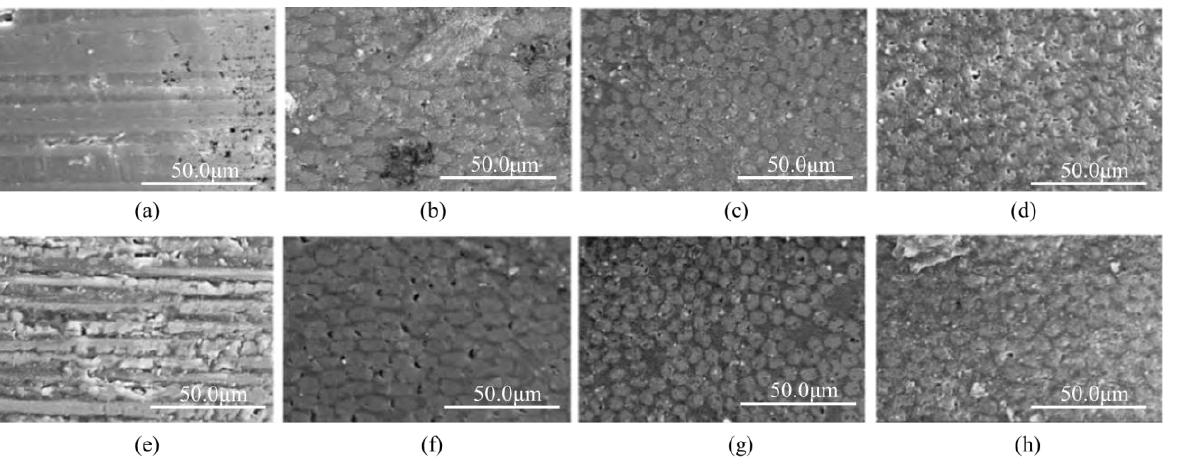
Figure 14. Surface morphologies of diced CFRP composites for metal-bonded blades at fiber orien- tations ( a ) 0°; ( b ) 40°; ( c ) 90°; and ( d ) 130° and for resin-bonded blades at fiber orientations ( e ) 0°; ( f ) 40°; ( g ) 90°; and ( h ) 130° [48].